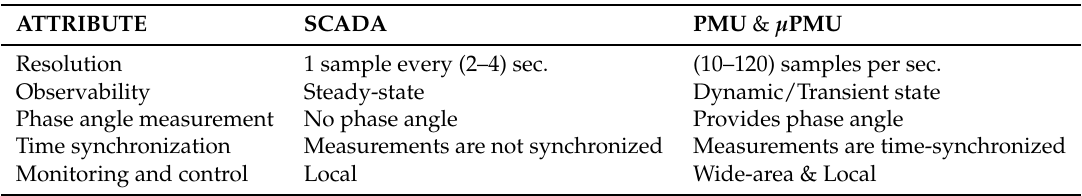
Table 1. Comparison of supervisory control and data acquisition (SCADA), Phasor Measurement Unit (PMU) and Micro-Phasor Measurement Unit ( µ PMU).